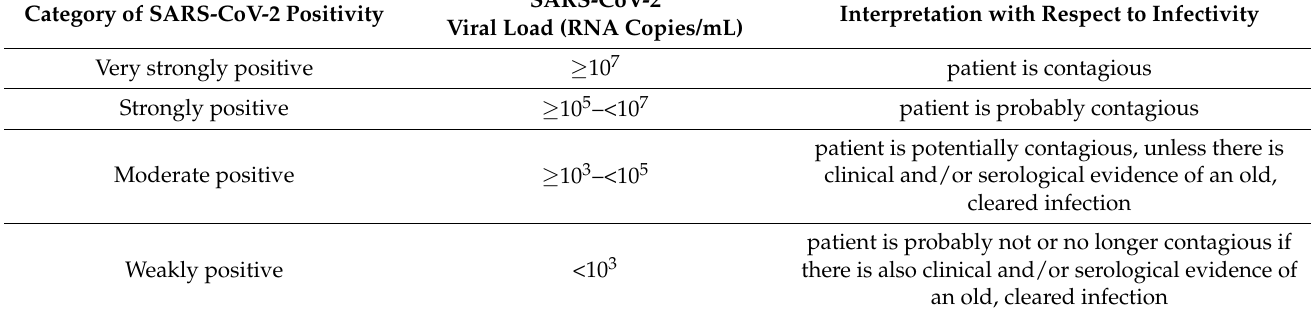
Table 1. Proposed interpretation and reporting scheme for SARS-CoV-2 PCR results [24]: a